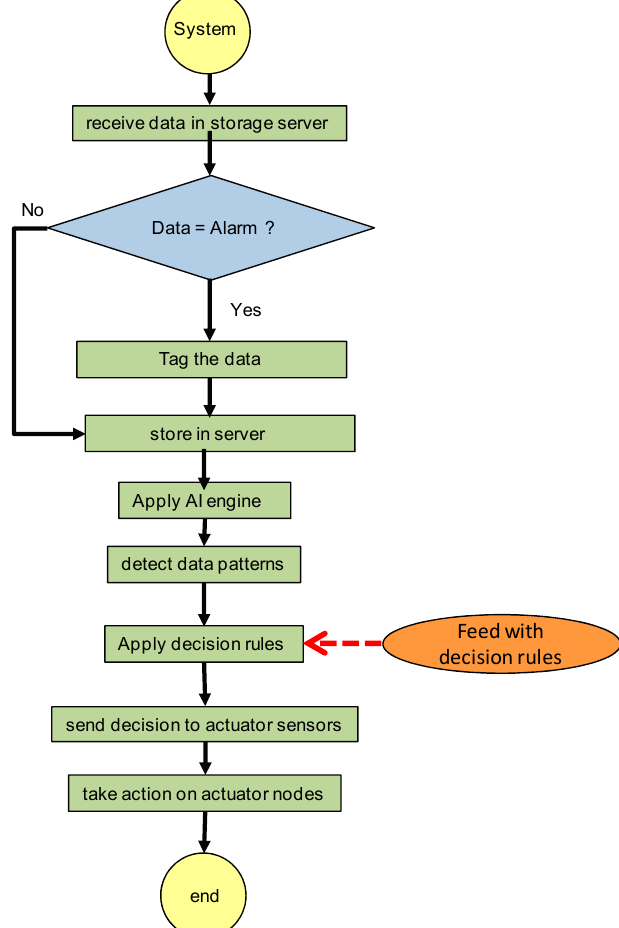
Figure 6. Algorithm for storage data, obtain patrons’ big data and take decision to actuator nodes.